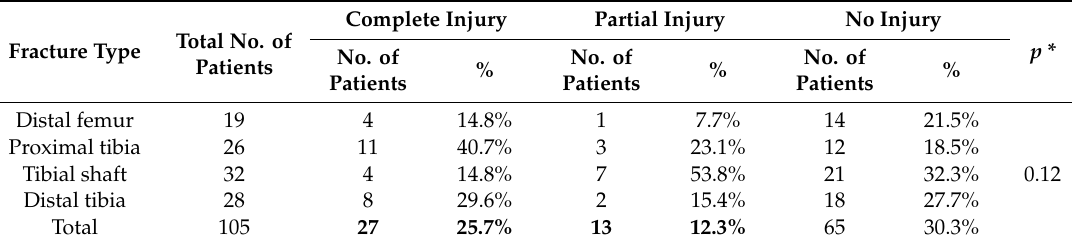
Table 1. The incidence of the TNAC injury according to fracture type for all patients.